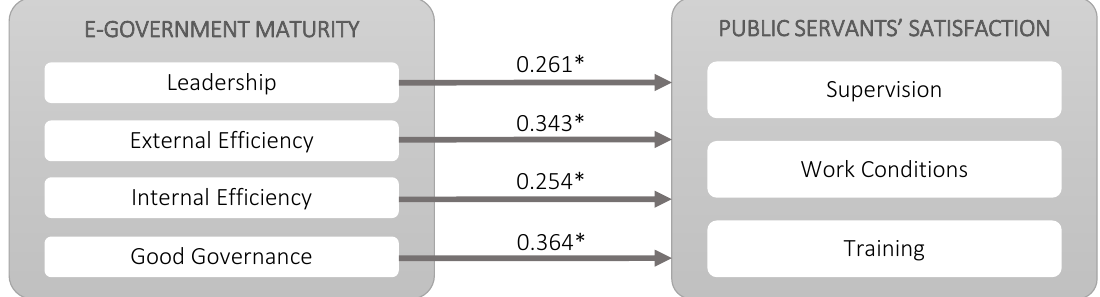
Table 16. One-way ANOVA test for ministry variable Sum of squares df